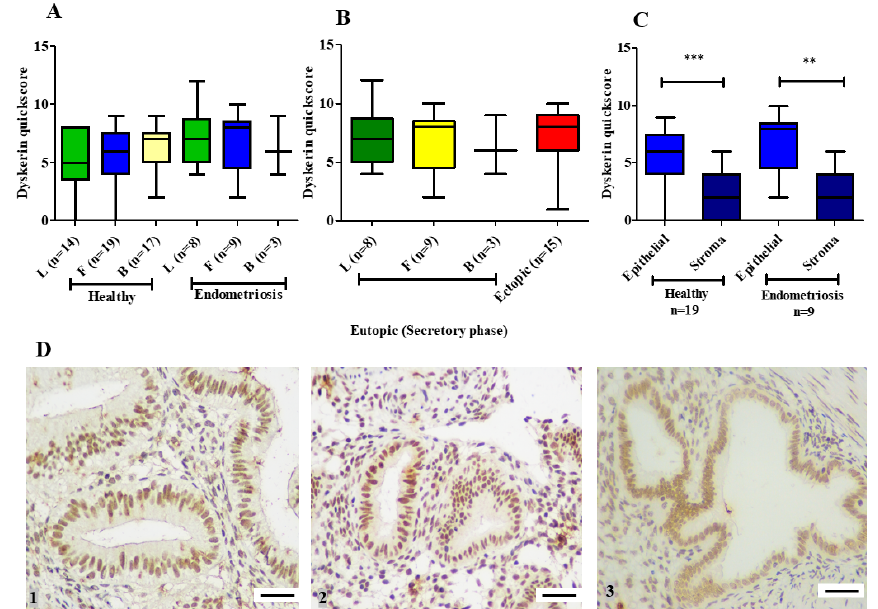
Figure 7. Dyskerin immunostaining in the healthy secretory phase, eutopic (secretory phase) endometrium from patients with confirmed endometriosis and ectopic endometriotic tissue ( A ) Dyskerin immunoscores in the three endometrial layers luminal (L), functionalis (F) and basalis (B) of healthy secretory phase compared with corresponding layers of eutopic endometrial samples from patients with endometriosis. ( B ) Dyskerin immunoscores comparison of L ( n = 8), F ( n = 9) and B ( n = 3) endometrial layers from eutopic secretory phase (SP) endometriotic samples with ectopic endometriotic lesions ( n = 15). ( C ) Dyskerin immunoscores in functionalis glands (FG) and stroma (FS) of SP samples from healthy women ( n = 19) and from women with confirmed endometriosis ( n = 9) ** p < 0.01, *** p < 0.001. ( D ) Representative microphotographs show dyskerin immunostaining in healthy endometrial secretory phase (1), eutopic endometrium from a patient with endometriosis (2) and ectopic endometriotic tissue (3). Positive staining appears brown. Magnification 400 × . Scale bar 50 µ m. ** p < 0.01, *** p <